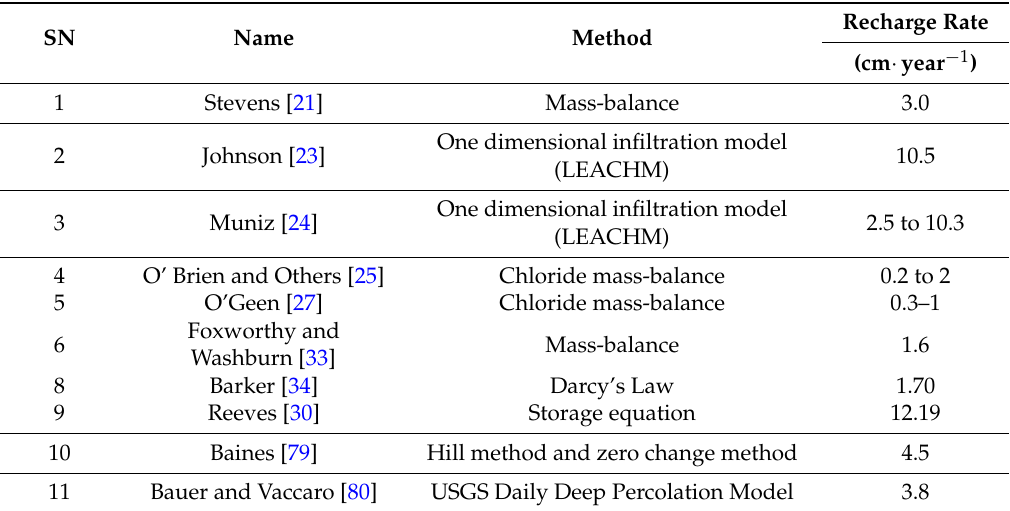
Table 3. Estimated Recharge Rates of Wanapum Groundwater Aquifer